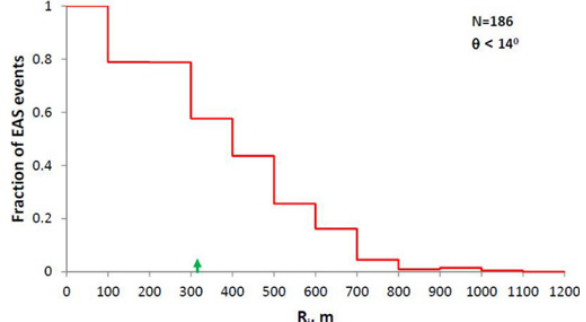
Figure 8. Axis distance distribution of the shower fraction detected with the